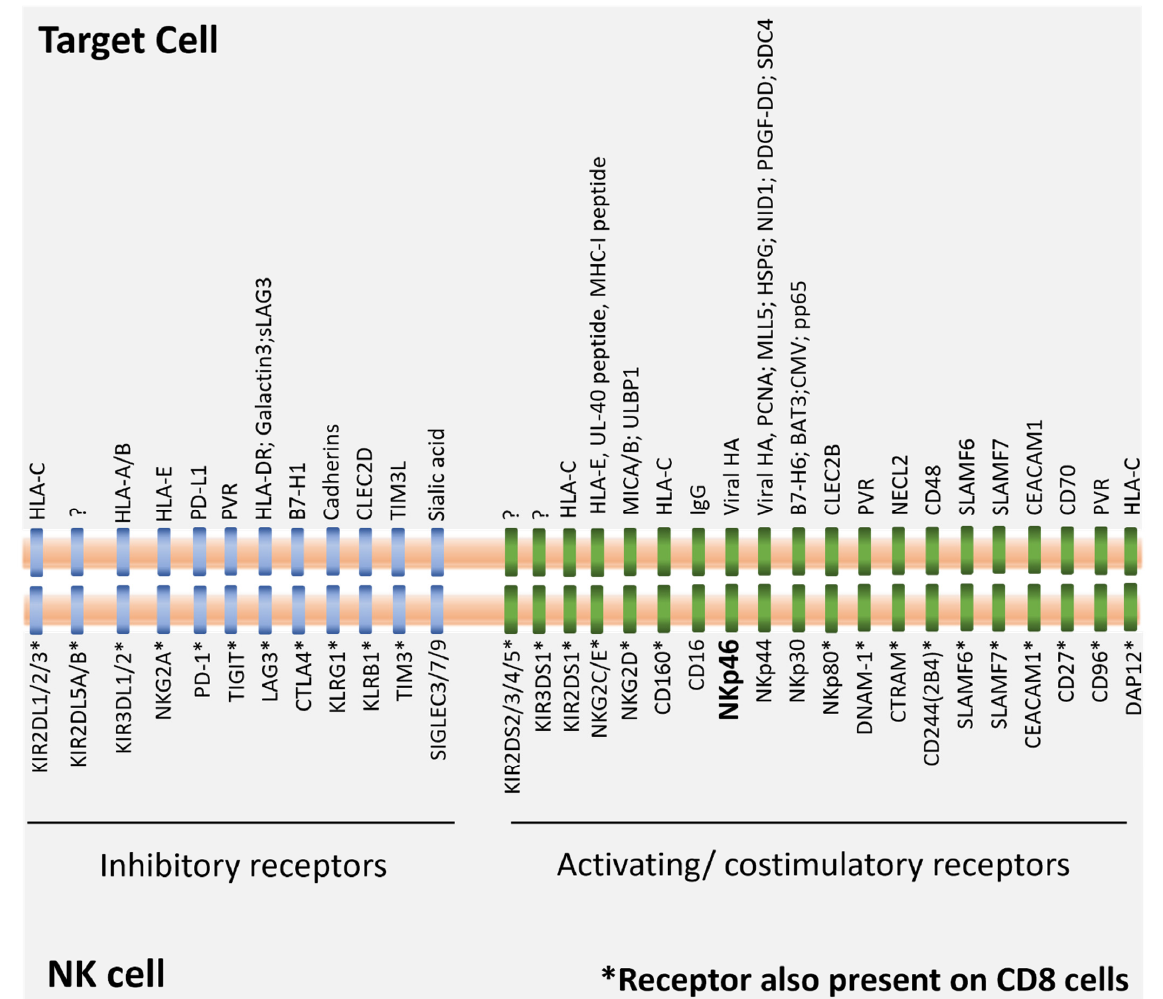
Figure 1 . Repertoire of NK cell receptors. Inhibitory receptors are represented in blue, while activating/costimulatory receptors are represented in green. Apart from NKp46, receptors regulating NK cells’ activity are also expressed by additional immune cells, particularly CD8.